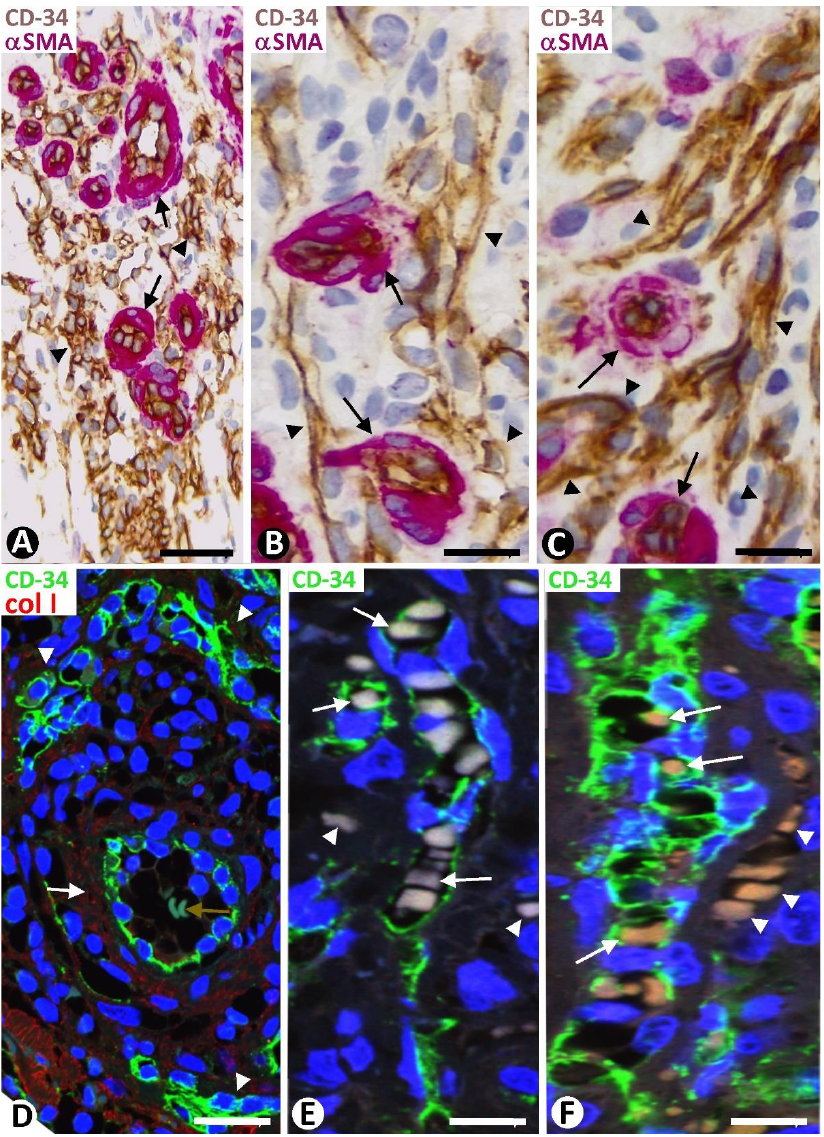
Figure 8. Type 2 neovessels in plaque stage of KS. ( A – D ): CD34+ neovessel ECs (brown in ( A – C ) and green in ( D )) (arrowheads) are observed around pre-existing blood vessels in which αSMA+ pericytes and vascular smooth muscle cells are seen (red, arrows). Note that neovessel ECs are present where delimiting CD34+SCs/TCs were located in non-affected vessels. ( E , F ): Red blood cells are observed in the neovessel lumen (arrows) and the interstitium (arrowheads). ( A – C ): Double immunochemistry for CD34 (brown) and αSMA (red). Hematoxylin counterstain. ( D ): Double immunofluorescence for CD34 (green) and collagen I (red). ( E , F ): Immunofluorescence for CD34. DAPI counterstain. Bar: ( A , D ): 35 µm; ( B , C , E , F ): 20 µm.